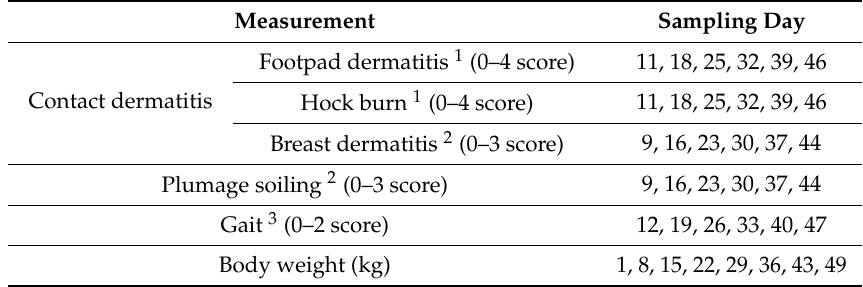
Table 2. Measurements (unit) and age of birds on sampling days. All categorical scoring systems were transformed to a continuous score using a tagged visual analog scale.